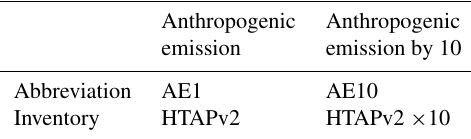
Table 1. Name and corresponding anthropogenic emission inven- tory of the two WRF-CHIMERE coupled simulations used in this